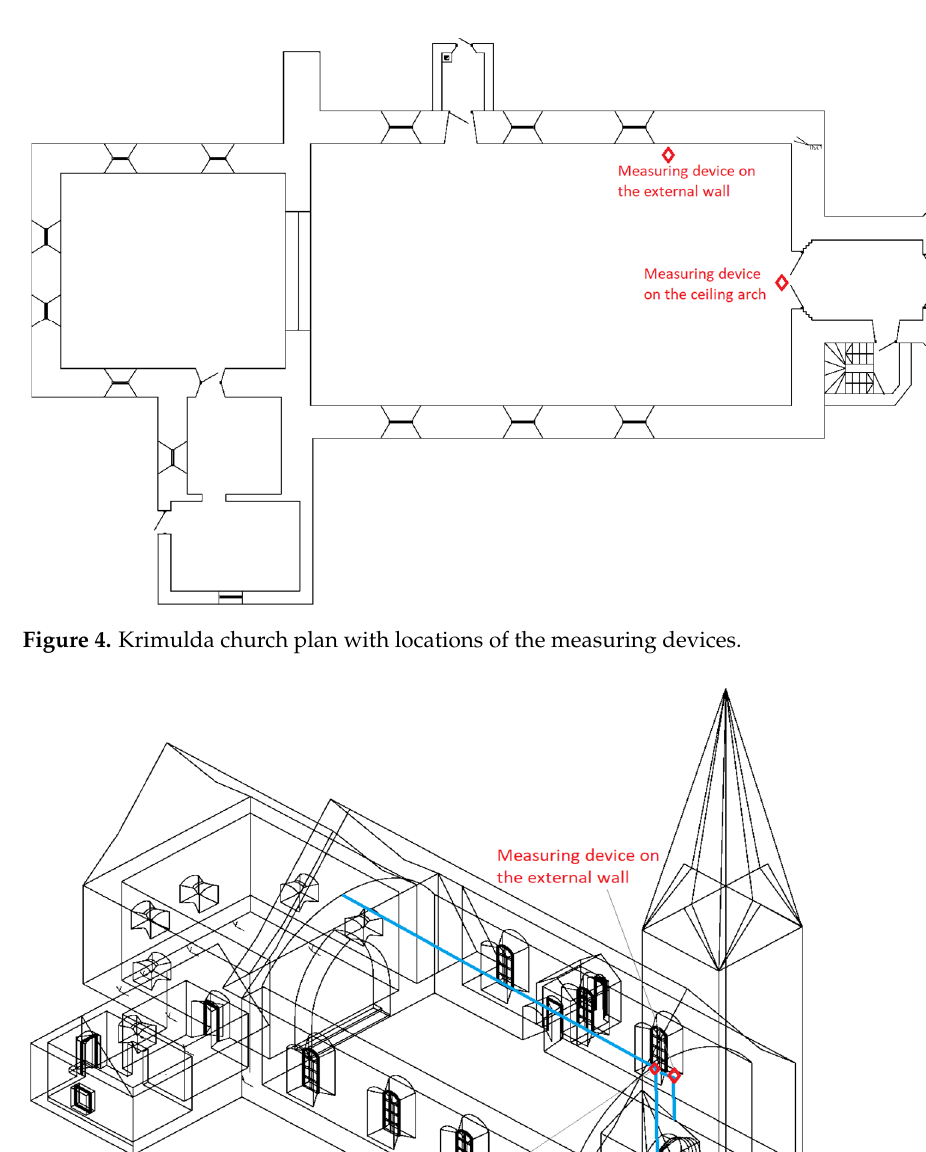
Figure 3. Example of mounting HOBO MX measuring instruments on the ceiling arch.